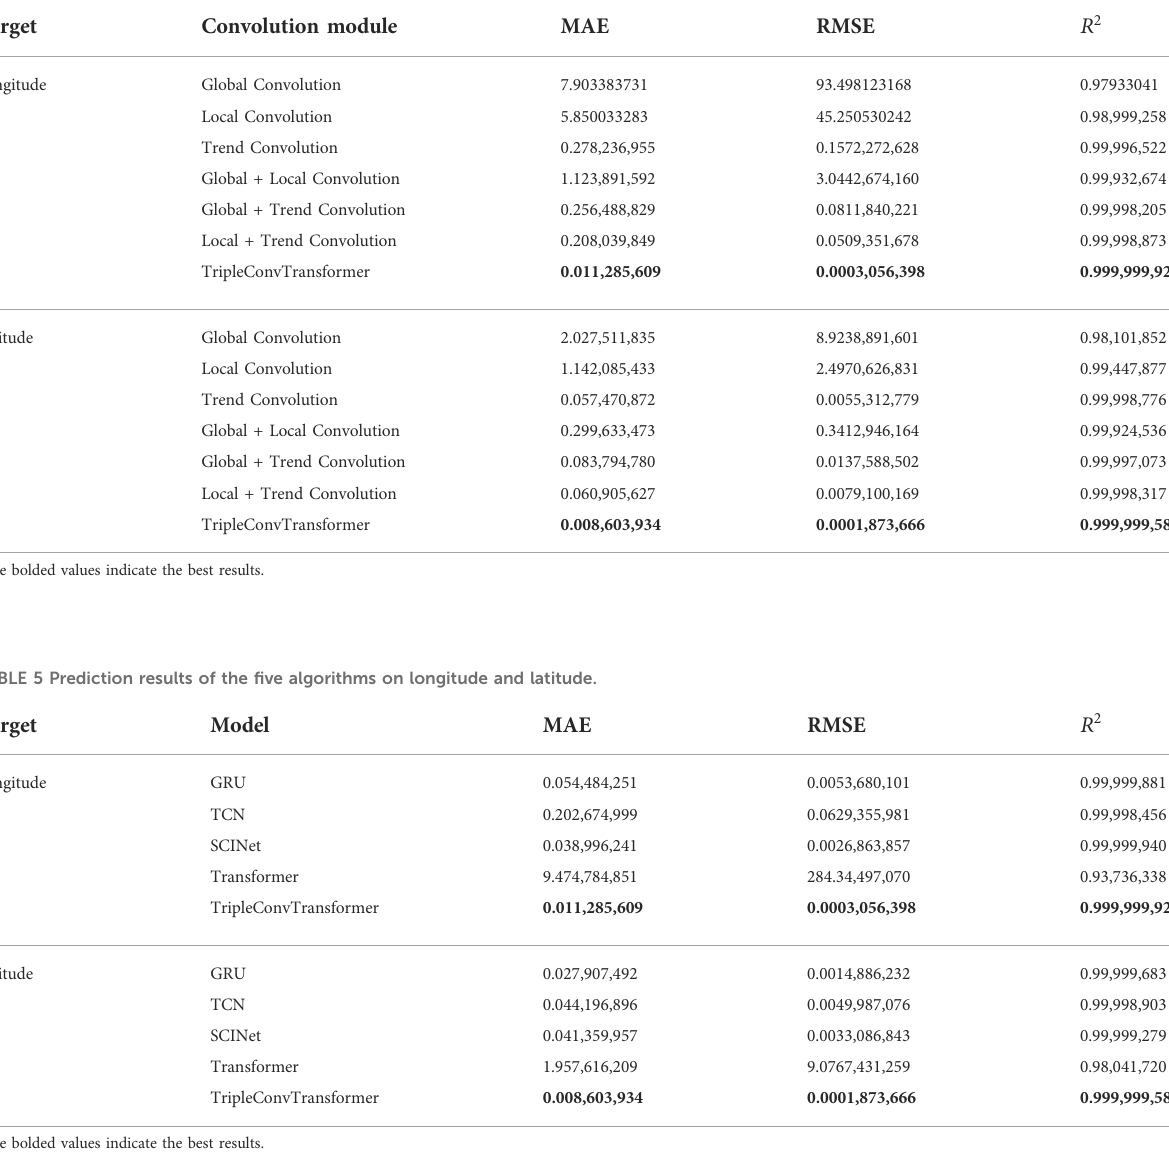
TABLE 4 Experimental results on the effectiveness of the three convolutional modules.